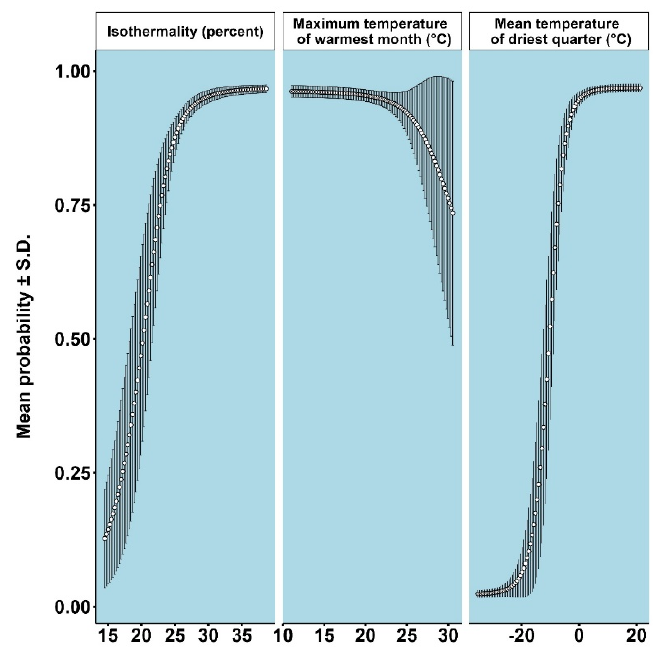
Figure 2. Mean probability ± S.D. of I. typographus presence at different values of the explanatory variable according to generalized linear models ( n = 30 per point) .